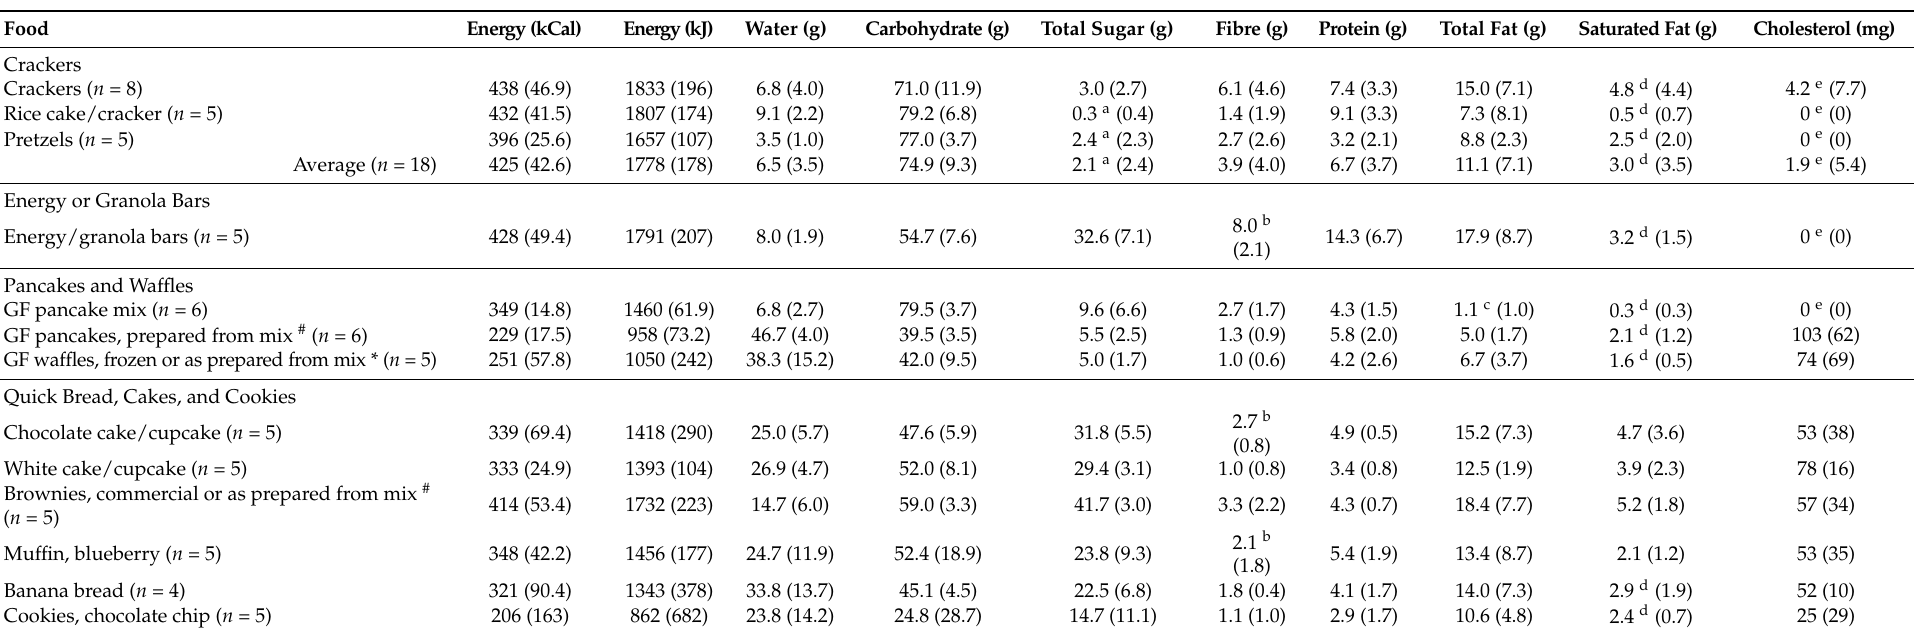
Table 3. Energy and macronutrient content of gluten-free sweets and snacks per 100 g